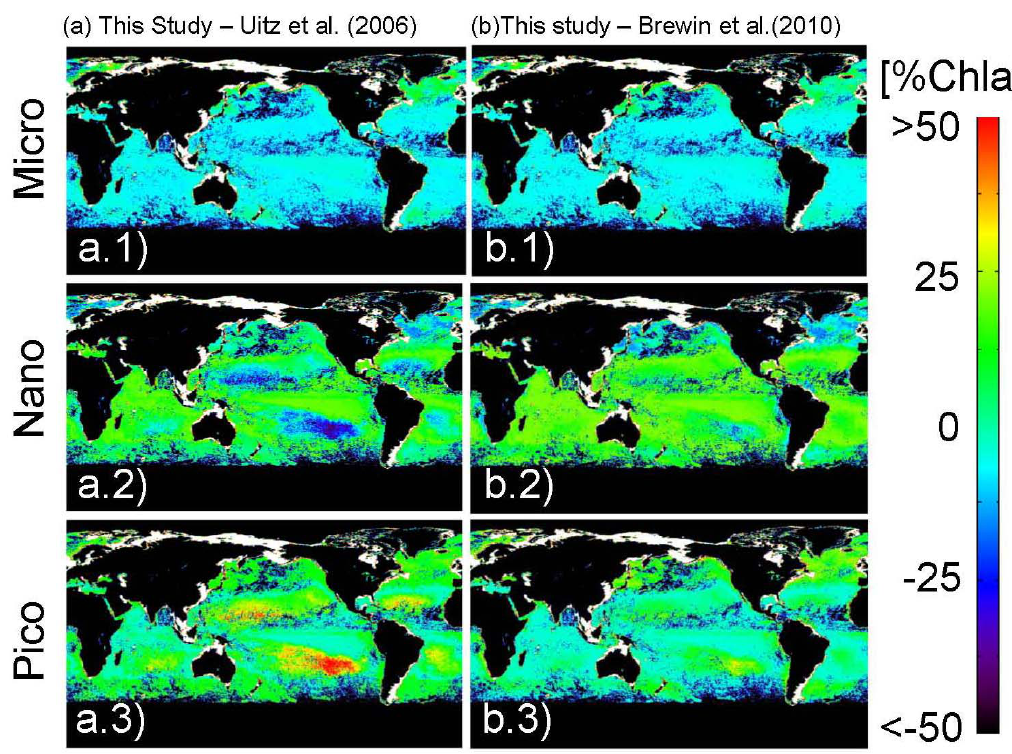
Fig. 9. Absolute deviation of PSCs in Chl- a (mg m − 3 ) between this study and Uitz et al. (2006) as well as between this study and Brewin et al. (2010) for May 2005.